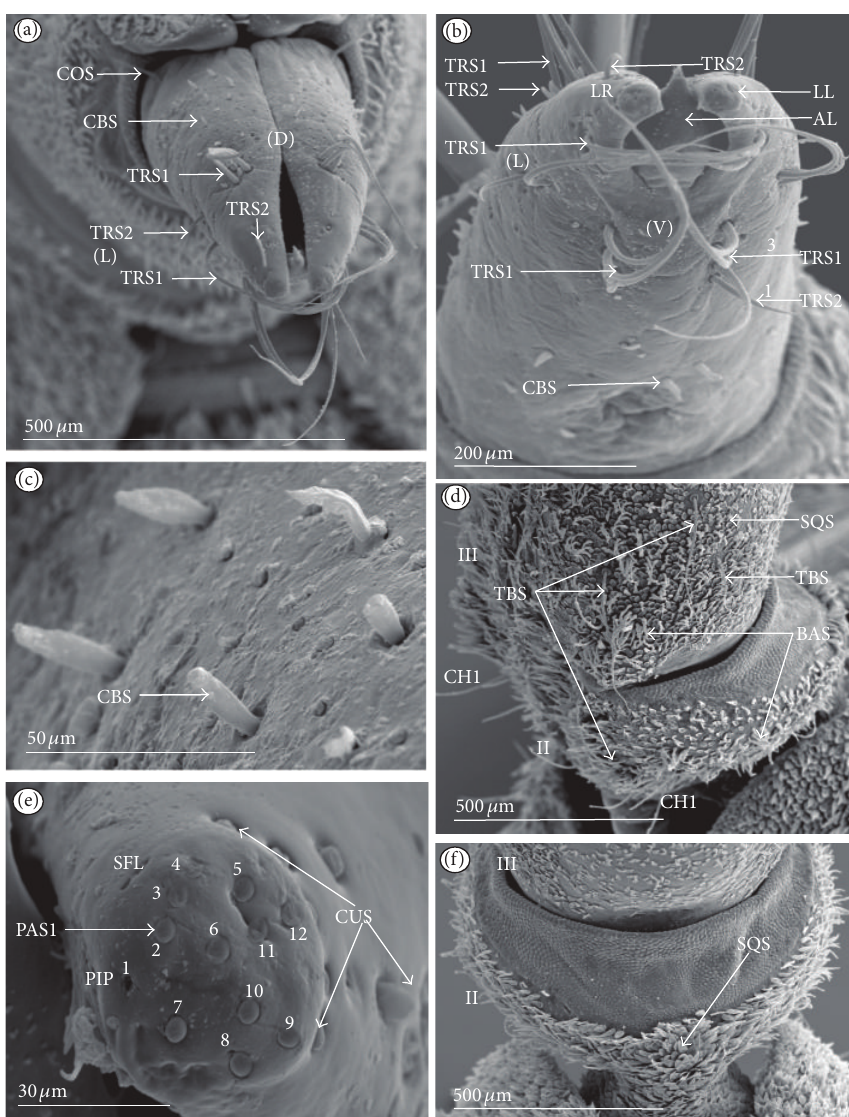
Figure 9: Types and sizes of sensilla of the Nepinae ( Laccotrephes japonensis ). (a) TRS1, TRS2 are placed dorsally (D) near of apex on the last segment of the labium, and TRS1, TRS2 are distributed laterally (L), CBS are distributed all over the surface of the last segment of the labium, and COS are visible in the proximal part of the IV segment. (b) TRS 1, TRS2 are placed ventrally (V) near the apex of the labium. LL: lateral left lobe, LR: lateral right lobe, Al, apical plate. (c) CBS are numerous and evenly distributed. (d) TBS, BAS, SQS, and CH1 are located dorsally and ventrally on III and II labial segment. (e) PAS1 (no. 2–12) and PIP (no. 1). (f) SQS are densely distributed over the ventral